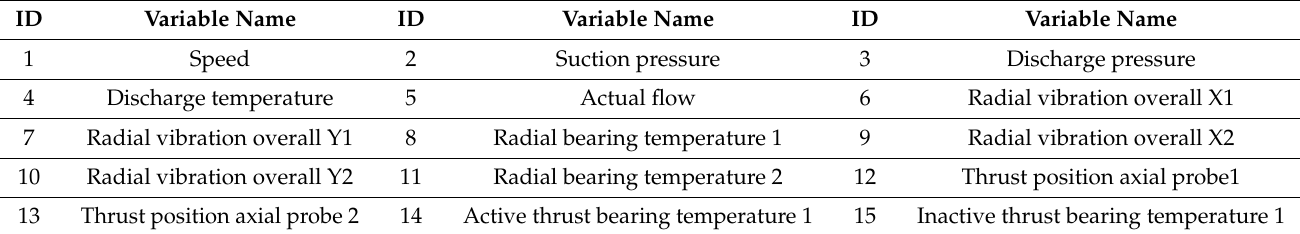
Table 2. Measurement variables in the pump monitoring